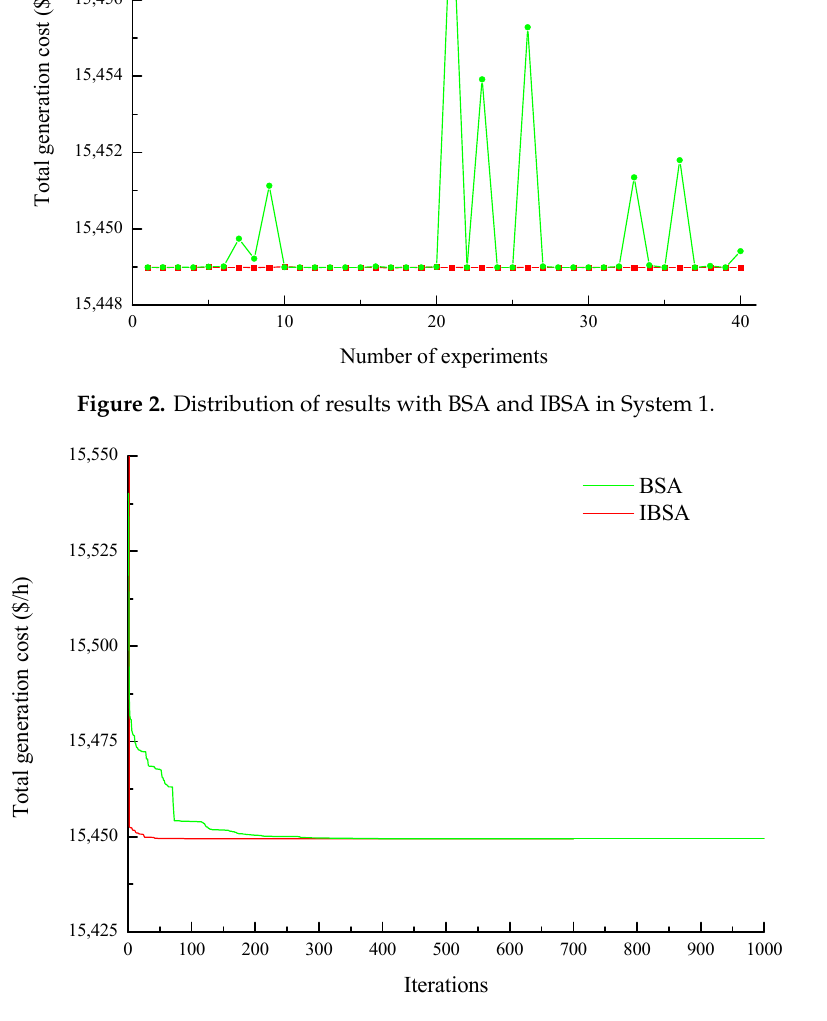
Figure 3. Convergence curve of Bird Swarm Algorithm (BSA) and IBSA in System 1.